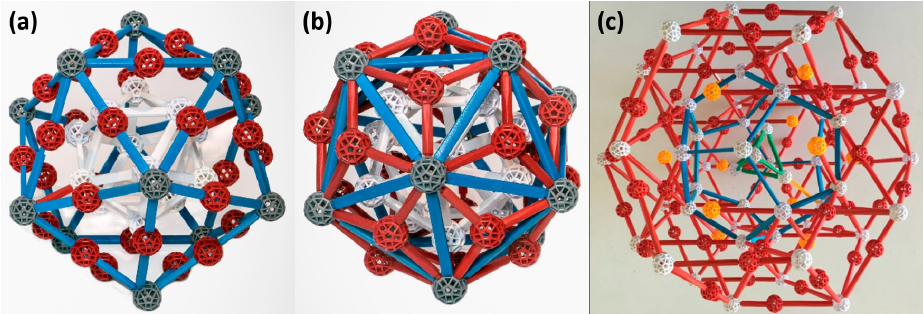
Figure 2. Models of Mackay ( a ), Bergman ( b ) and Tsai ( c ) clusters, reproduced from reference [46]. A one-dimensional Fibonacci sequence constitutes the simplest case of quasicrystal- line arrangement [47]. In the Fibonacci sequence the sum of the two preceding numbers forms the next number. The ratio of two consecutive numbers is close to τ = (1 + √ 5)/2 = 1.61803398875 and is called the “golden ratio”. If two segments are selected, with L repre- senting a longer segment and S a shorter segment, then to form the quasicrystalline ar- rangement, the shorter segment S is replaced by a longer segment L and the combination SL replaces the longer segment L. This results in a following sequence